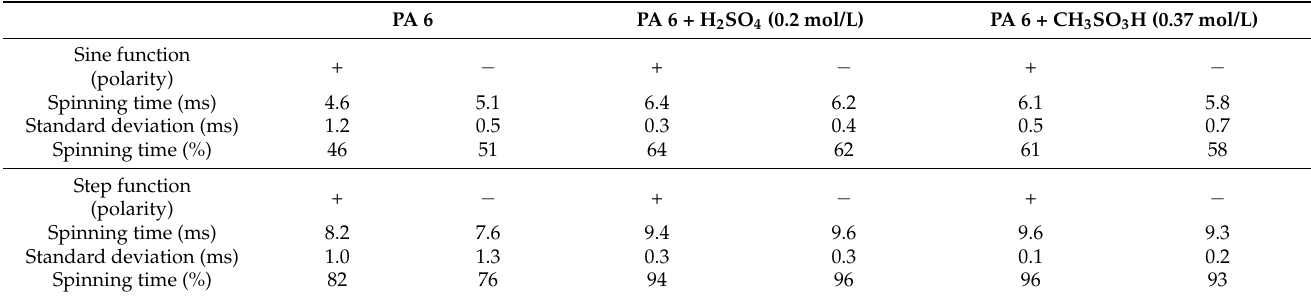
Table 1. Overview of the three PA 6 solutions and their reaction to the HV signal.